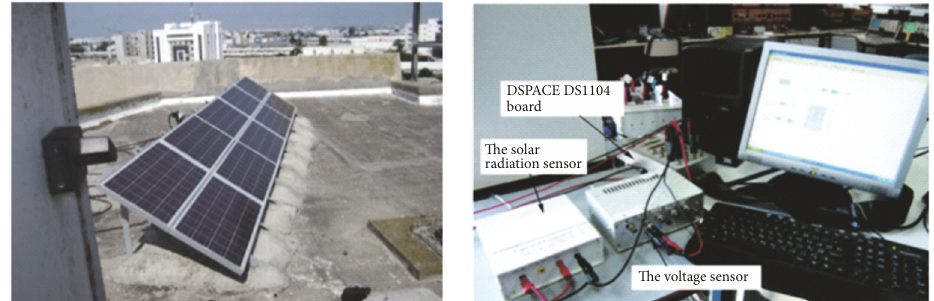
Figure 9: Configuration of the studied system.